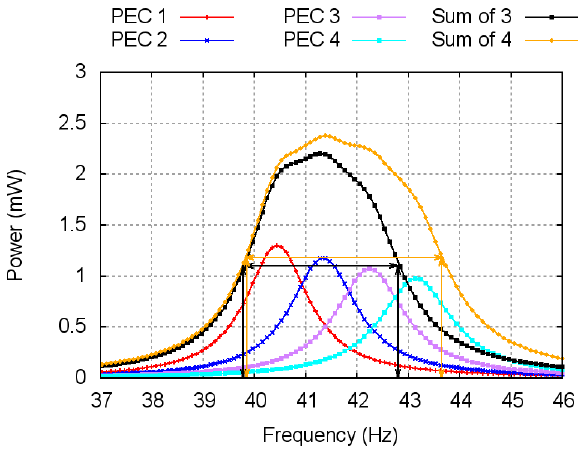
Figure 4. Simulated resonance curves of piezoelectric cantilever beam arrays.